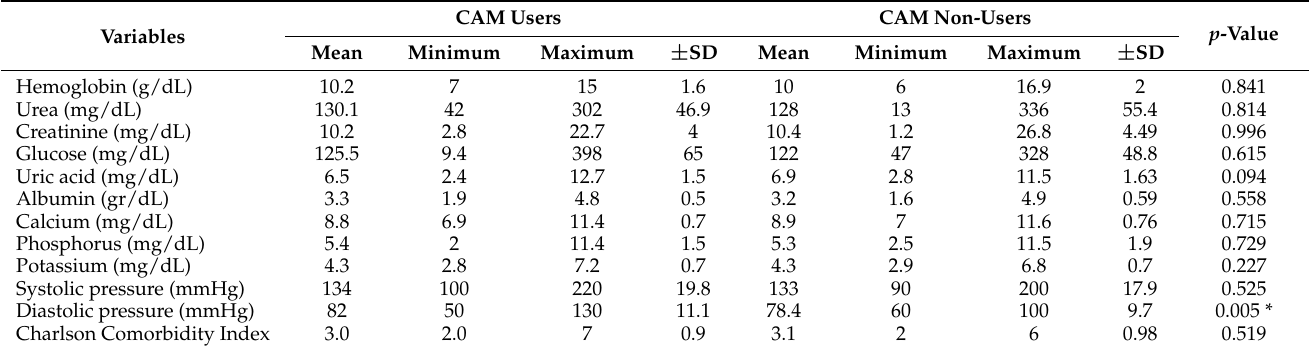
Table 5. Biochemical parameters and clinical characteristics of